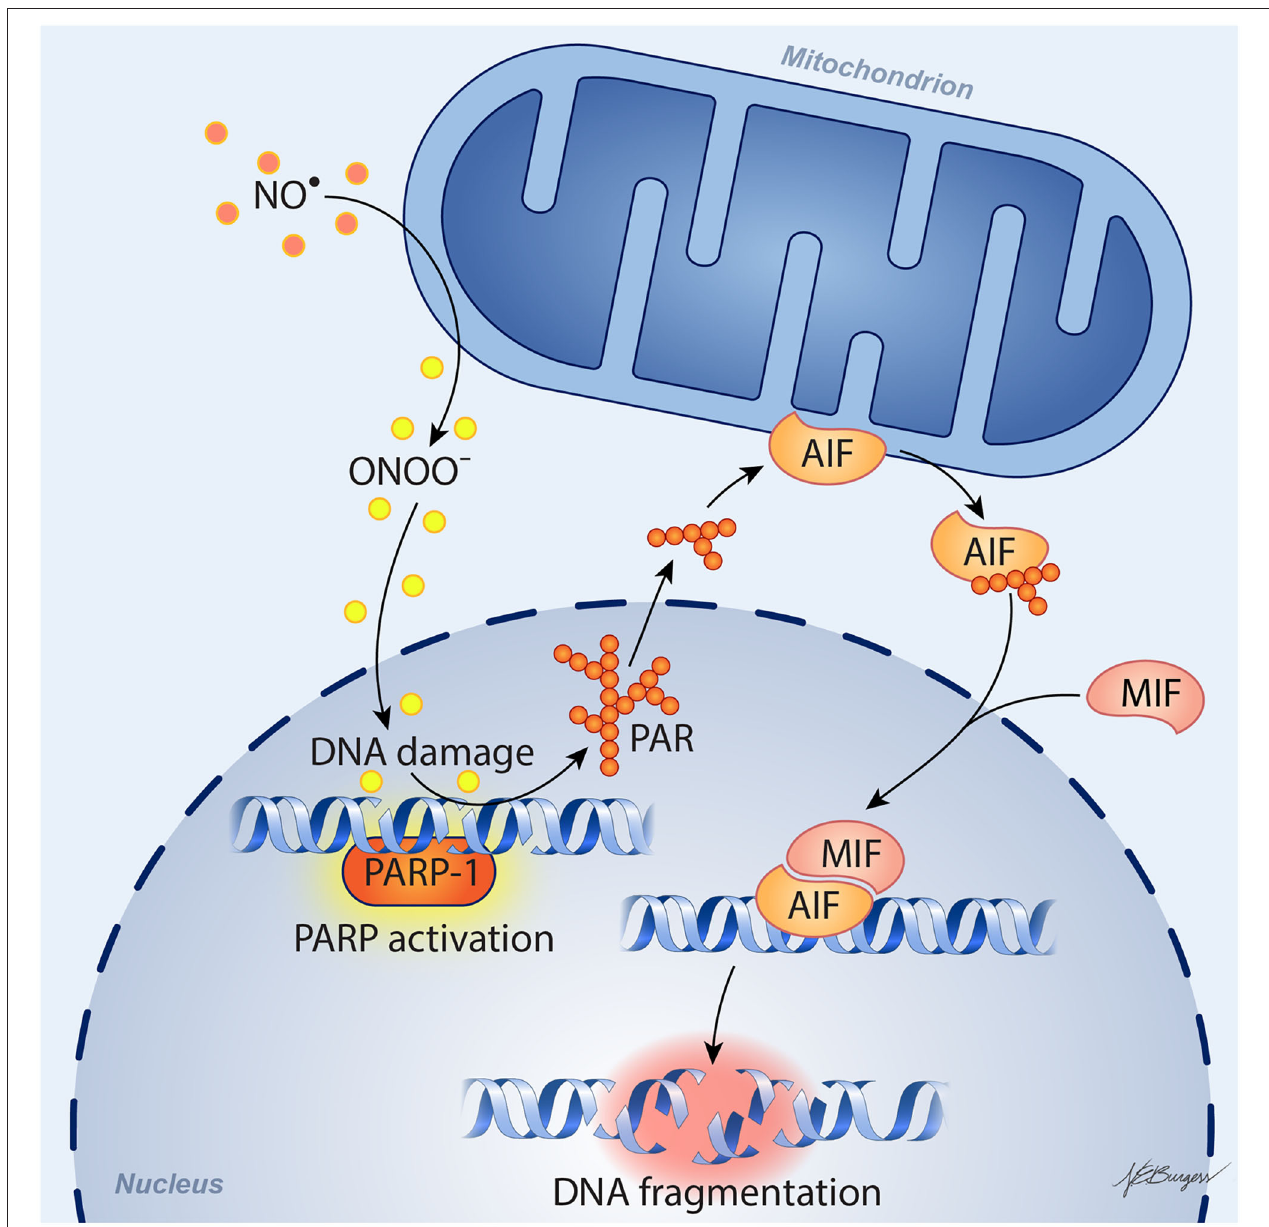
FIGURE 1 | Schematic diagram of parthanatos signaling. Activation of NMDA receptors stimulates neuronal nitric oxide (NO) synthase (nNOS). Ischemia and reperfusion lead to excess superoxide production in mitochondria and from NADPH oxidase. The abundant NO and superoxide spontaneously generate peroxynitrite (ONOO − ). This strong prooxidant, along with other reactive oxygen species (ROS), damages DNA strands and thereby causes activation of poly(ADP-ribose) polymerase (PARP). When the DNA damage is great, the consequent over-activation of PARP leads to abundant PAR polymer formation in the nucleus; some of the poly(ADP) ribosylated carrier proteins exit the nucleus and cause the release of apoptosis-inducing factor (AIF) from a pool on the outer mitochondrial membrane. Once in the cytosol, AIF can bind to macrophage migration inhibitory factor (MIF). Together, they enter the nucleus and produce large-scale DNA degradation and cell